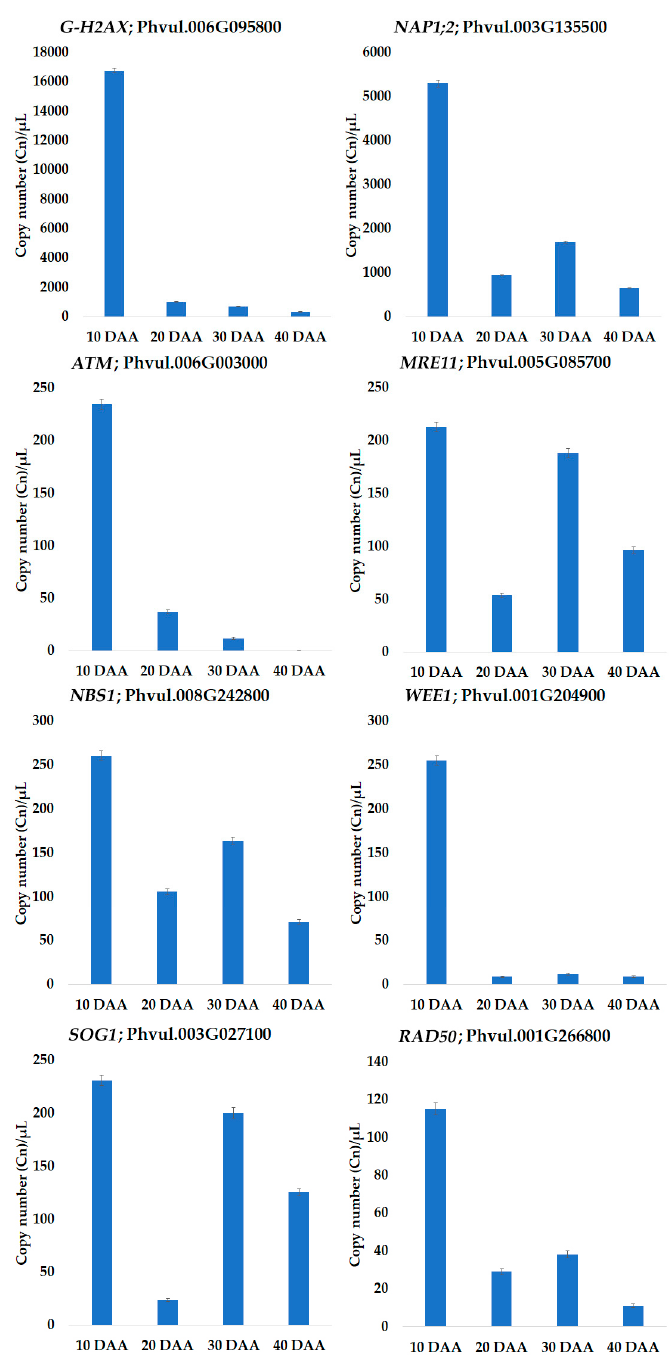
Figure 4. Bar plots represent mRNA copy number per microliter (Cn/µL) of biological quadruplicates for the eight genes selected for digital PCR. The Cn/µL was calculated using QuantStudio™ 3D Analysis Suite™ assuming a Poisson distribution; error bars correspond to the theoretical confidence interval. The precision of quantification of ATM at 40 DAA and WEE1 at 20 and 40 DAA was higher than 10%. Y-axis: Cn/µL; X-axis: days after anthesis (DAA).